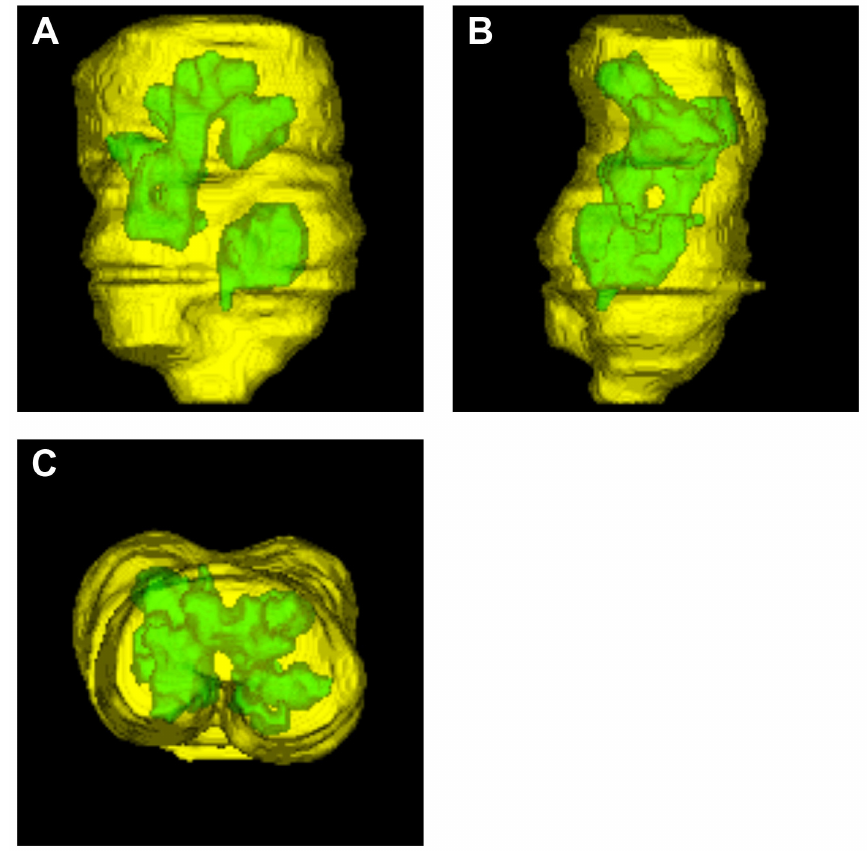
FIGURE 4. 3D rendering of the composite lesions using Analyze® software in three projections: anterior/posterior (A), lateral (B), and inferior